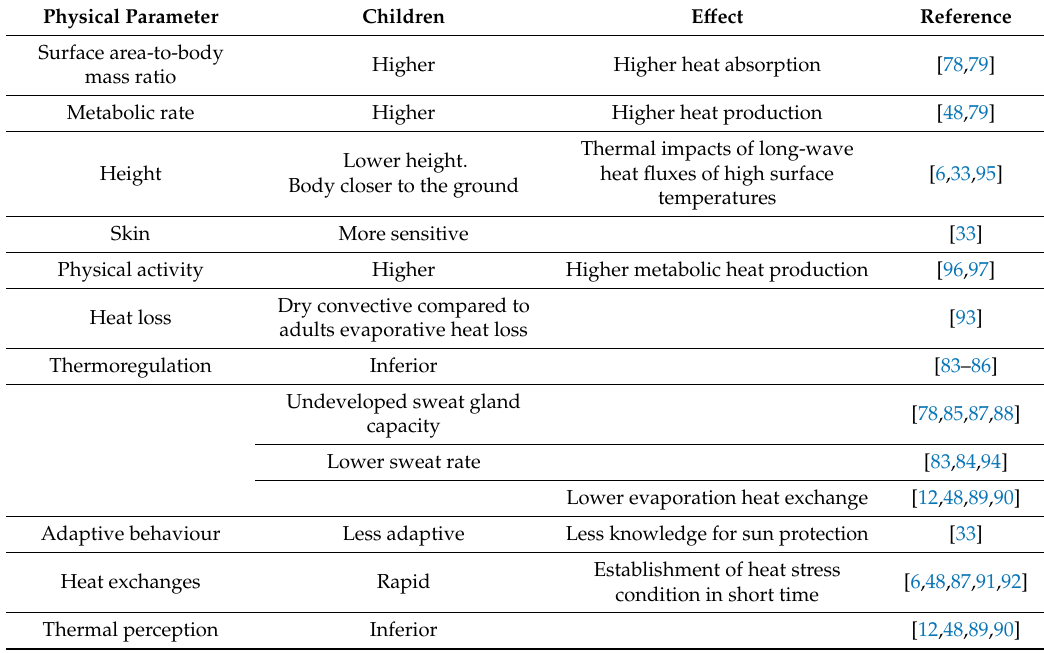
Table 2. Physiological di ff erences between children and adults that trigger di ff erences in children’s thermal perception in hot